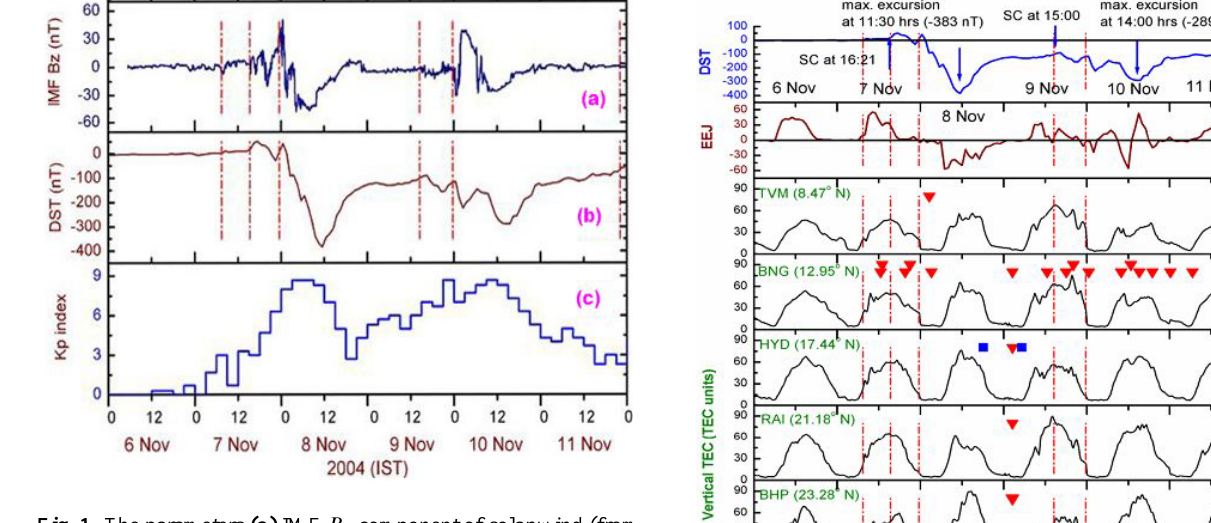
Fig. 1. The parameters (a) IMF B z component of solar wind (from ACE data); (b) the D st index of geomagnetic activity (the verti- cal red (dotted) lines represent the storm sudden commencements generated by interplanetary shocks); and (c) the K p index.